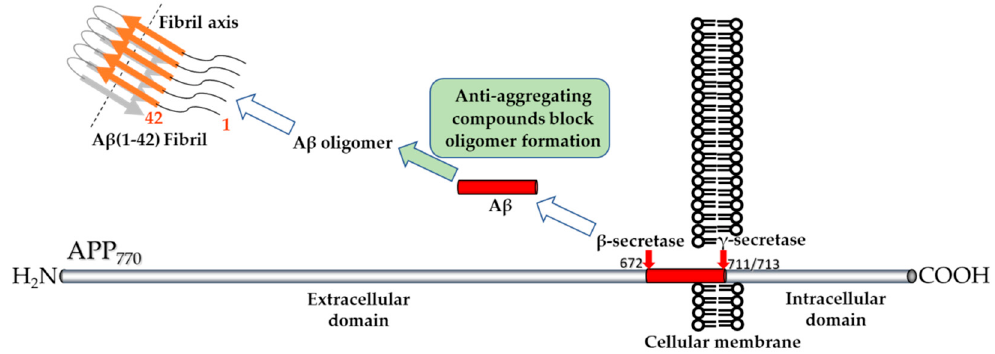
Figure 1. Schematic representation of the therapeutic strategy based on the finding of an A β aggregation inhibitor. Cleavage of the amyloid precursor protein (APP) containing 770 amino acids, by β -secretase in the extracellular domain after methionine-671 and by γ -secretase in the transmembrane domain after valine-711 and alanine-713 produces in the extracellular medium the free peptides A β (1–40) and A β (1–42). Both peptides form oligomers and fibrils. Anti-aggregating compounds which inhibit the oligomerization of the amyloid peptides are searched.